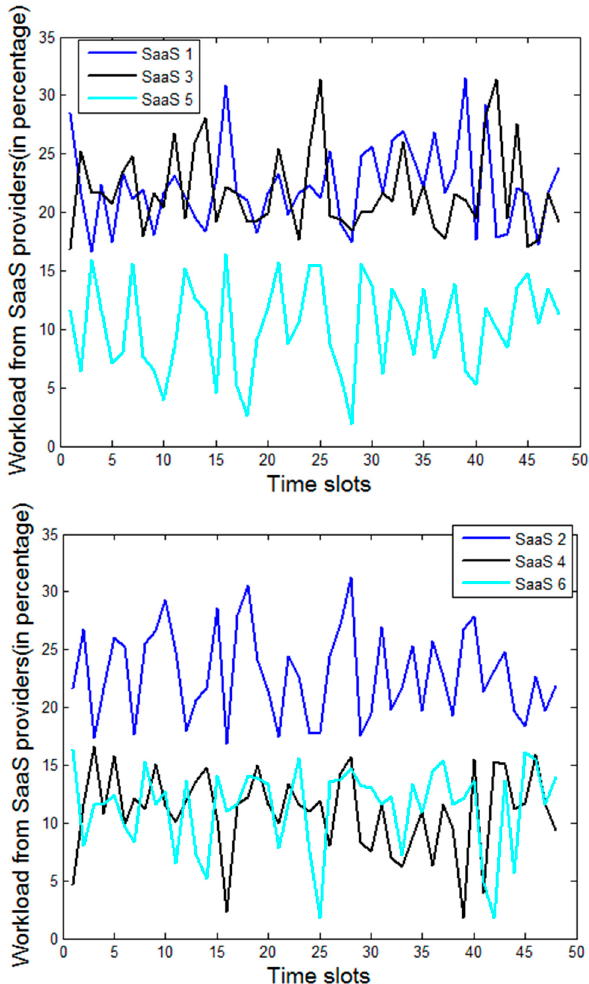
Figure 6. The percentage share of the individual SaaS providers in the total workload generated.